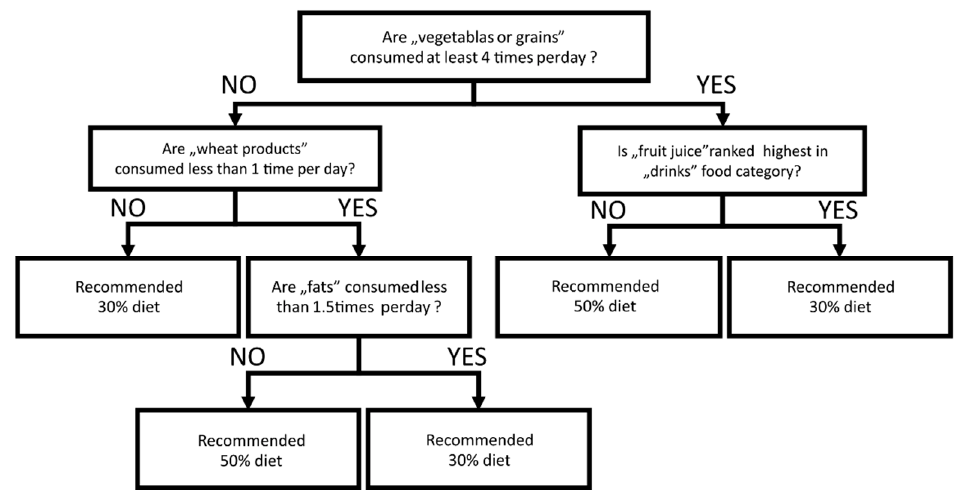
Figure 3. Decision-tree diagram for classification and regression trees (CART) analysis. Influence of FFQ-6 measured nutritional habits in the benefit of glycaemic control after dietary intervention (30% or 50% carbohydrate diet). Table 4. Coefficient determination (R 2 ) and beta coefficients for multivariate linear regression models for change in selected glycaemic variability indices between the diets ( ∆